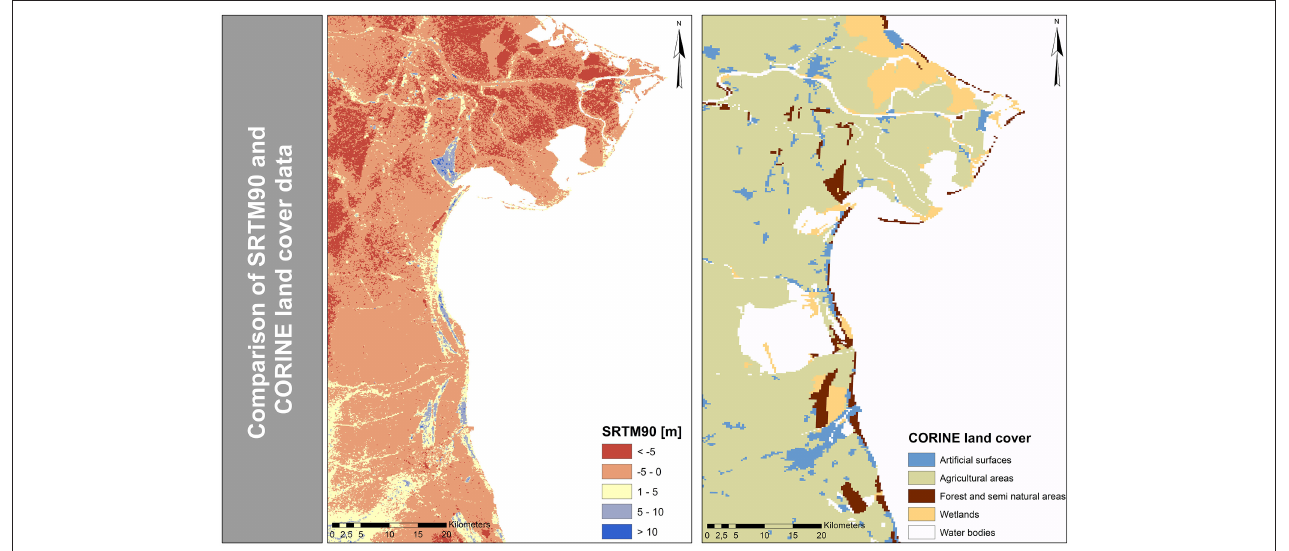
FIGURE 9 | Comparison of the SRTM90 digital elevation data and CORINE land cover data in